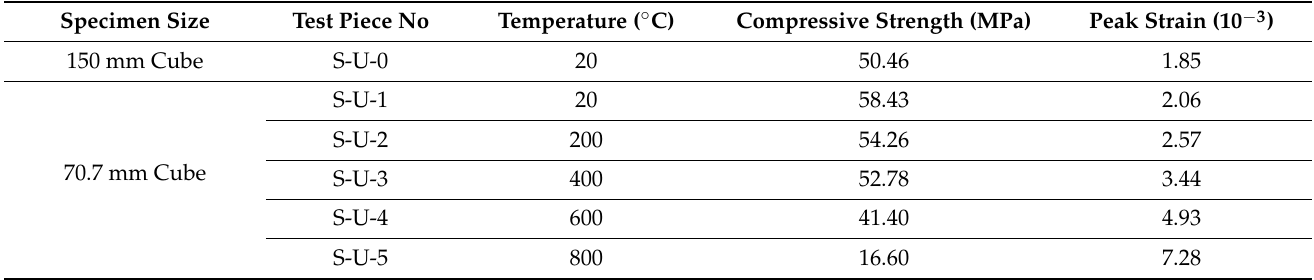
Table 6. High-temperature uniaxial static compression test results of concrete.